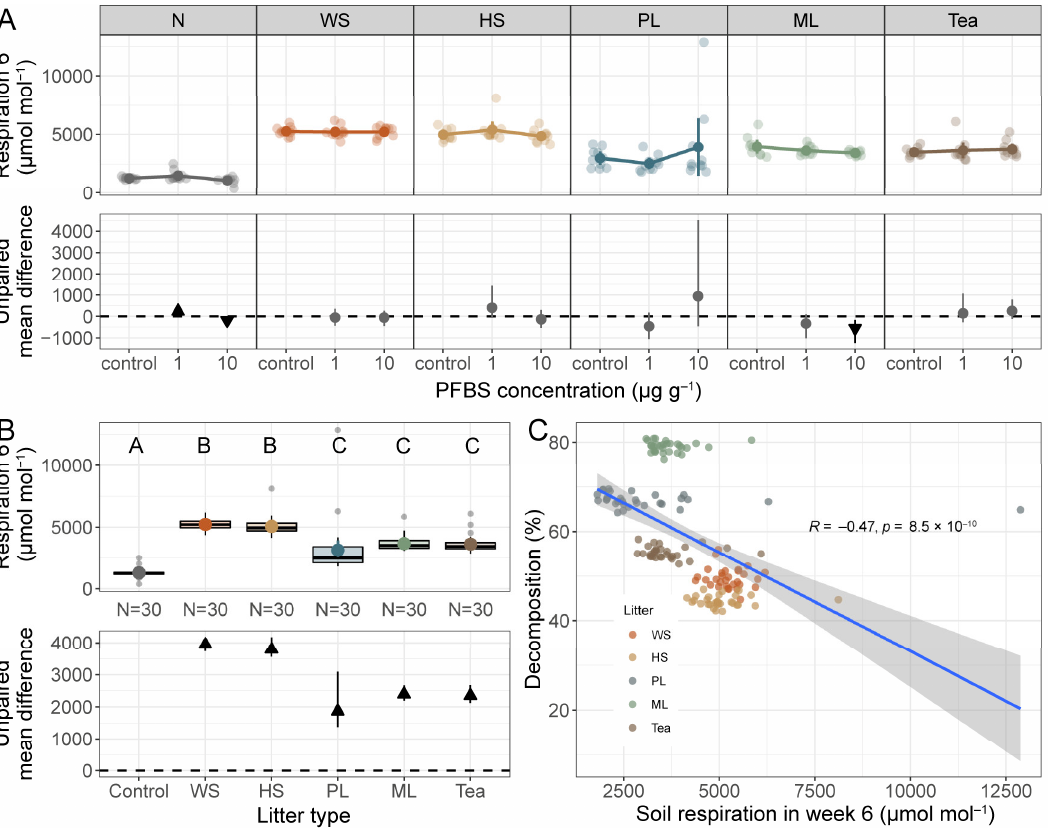
Figure 2. ( A ) Response of soil respiration (week 6) to PFBS treatments within litter type; ( B ) Response of soil respiration (week 6) to litter type regardless of PFBS concentrations; ( C ) Correlation of soil respiration (week 6) with litter decomposition. The second row of the panel ( A ) showed the comparison of the unpaired mean difference between the treated and control group within a 95% confidence interval (CI). The grey spots indicated the neutral effects while the black arrows pointing upwards and downwards represented positive and negative effects, respectively. Different letters above the boxes in panel ( B ) indicated statistically significant differences among treatments at p < 0.05. N, no litter; WS, wheat straw; HS, hemp stem; PL, Plantago lanceolate ; ML, Medicago lupulina .